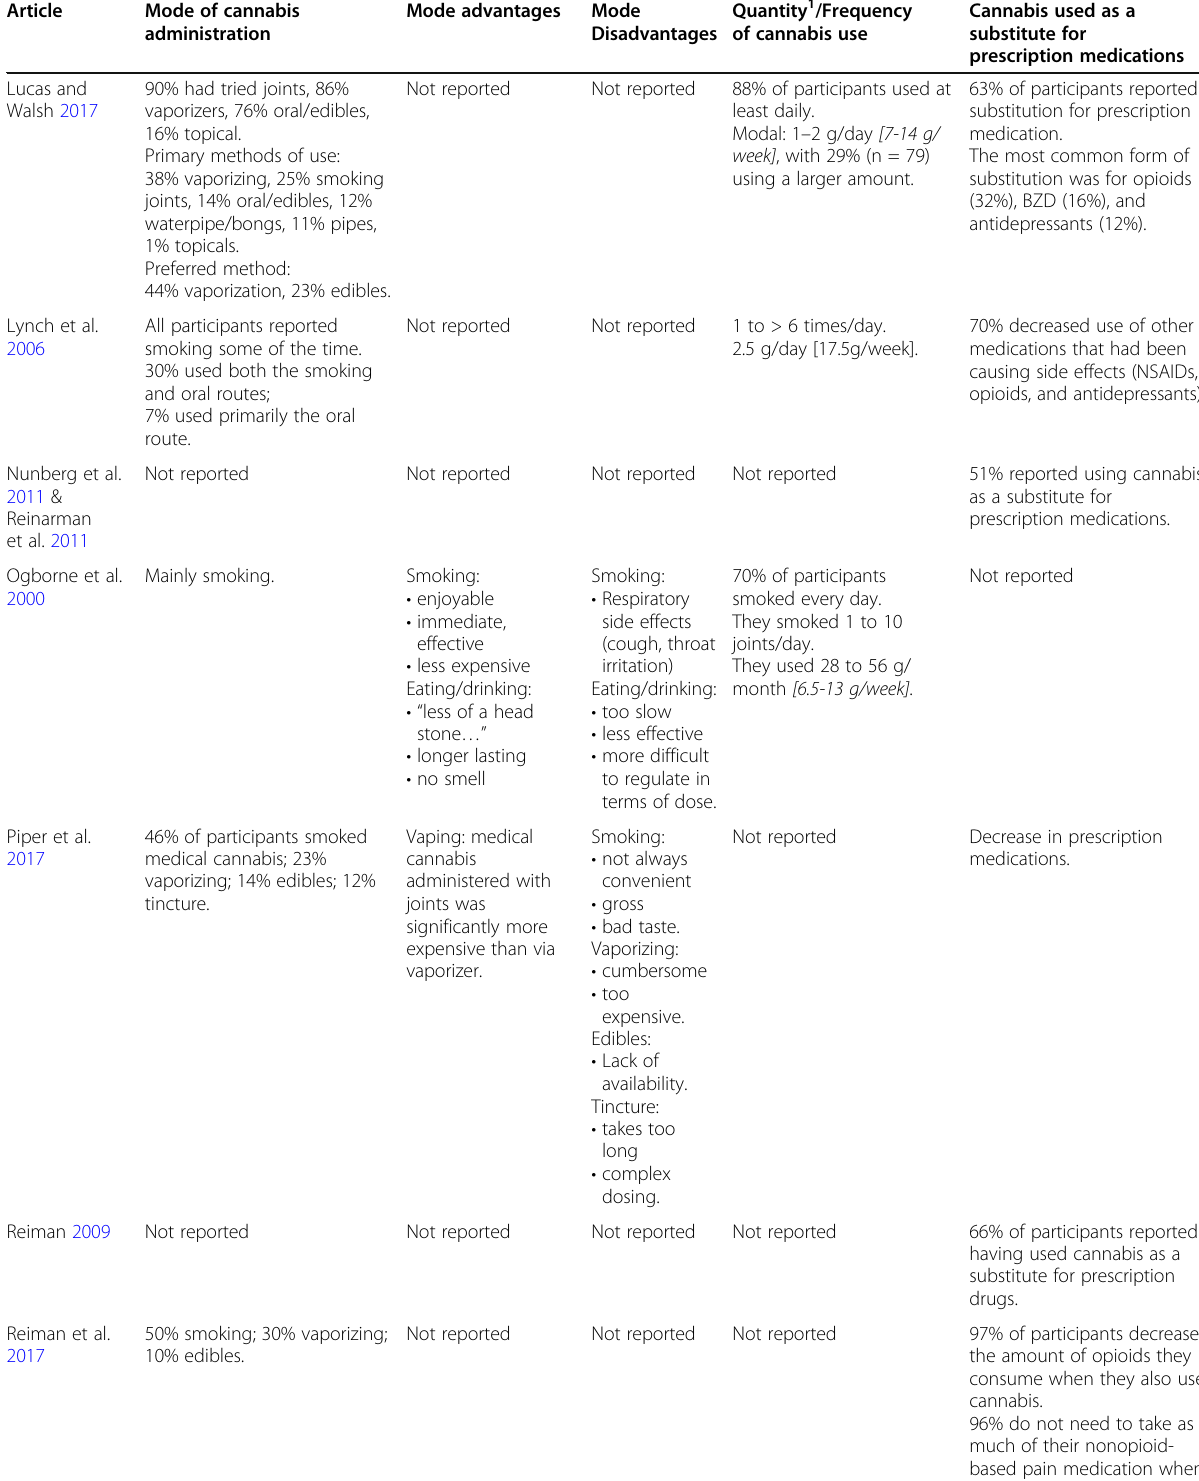
Table 2 Patterns of medical cannabis use and utilization of medical cannabis as a substitute for prescription medications